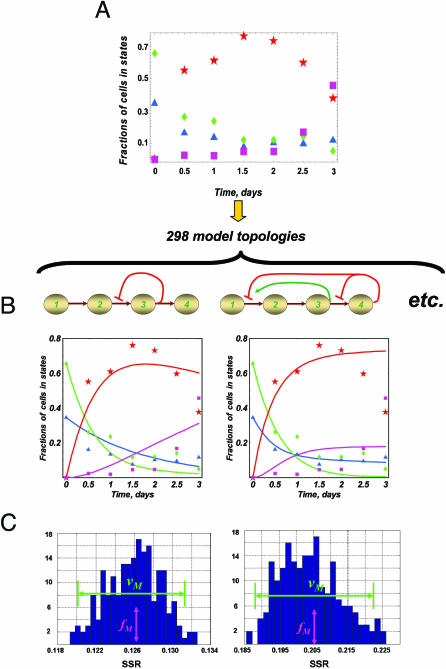
Generation and Analysis of the 298 Distinct Model Topologies Used in the Computational Analysis(A) The relative numbers of cells in four states over the time course of the erythropoietic wave shown in Figure 1 were evaluated (Protocol S1, section 1.1) and plotted versus time. The fractions of cells in state 1 (blue triangles), 2 (green rhombs), 3 (red stars), and 4 (magenta squares) are shown.(B) The model topologies were generated by allowing up to three independent feedback and feedforward interactions between different states, so that the fractions of cells in some of the states might affect the transition probabilities between pairs of successive states. Each model topology was then fitted to the data shown in (A). Two examples of the possible 298 topologies and the corresponding best fits are shown.(C) For each model topology, the parameters determined during the fitting process were then varied within a 5% range, resulting in 200 predictions for the corresponding model topology, each with its associated SSR. The distributions of SSR values for two such model topologies are shown. The mean SSR value, fM, is computed, as well as its variance in the distribution, vM. These values are recorded for all the model topologies and then used to calculate the Fj and Rj metrics for each of the possible feedback and feedforward interactions, shown in Figure 4.